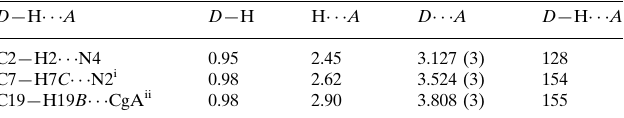
Hydrogen-bond geometry (A˚ , (cid:1)